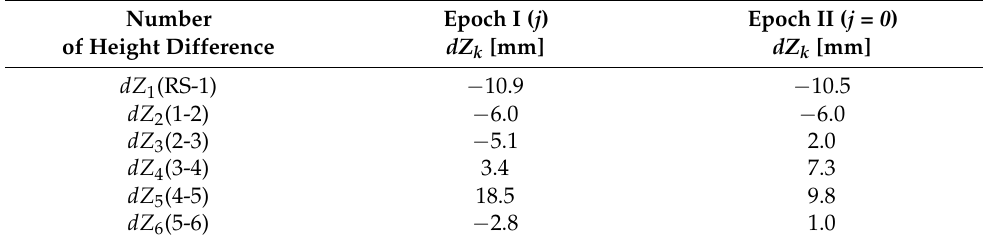
Table 2. The results dZ k obtained from epoch I and epoch